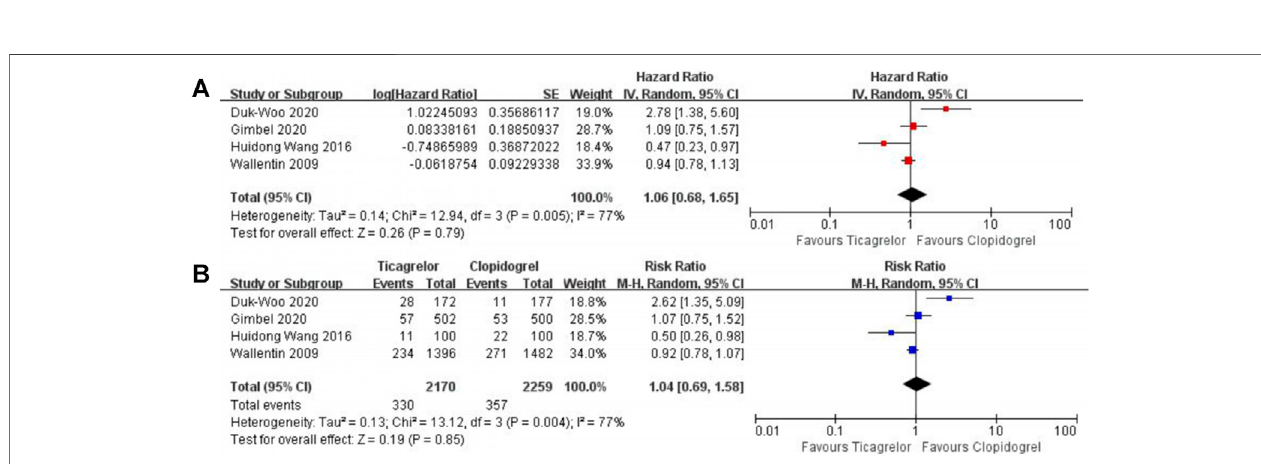
FIGURE 3 | Meta-analysis with HR (A), RR (B) , and 95% CI for cardiovascular death. Boxes are the relative risk estimates from each study; the horizontal bars are 95% CI. The size of the box is proportional to the weight of the study in the meta-analysis. HR, hazard ratio; RR, risk ratio; CI, con fi dence interval.